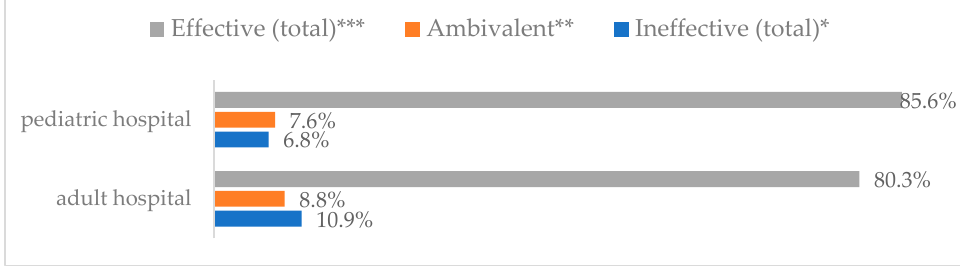
Figure 8. Hand washing as a means of preventing influenza virus infection by type of hospital ( N = 905). *Sum of responses: completely ineffective, ineffective, rather ineffective; **Response: neither ineffective nor effective; ***Sum of responses: rather effective, effective, completely effective.